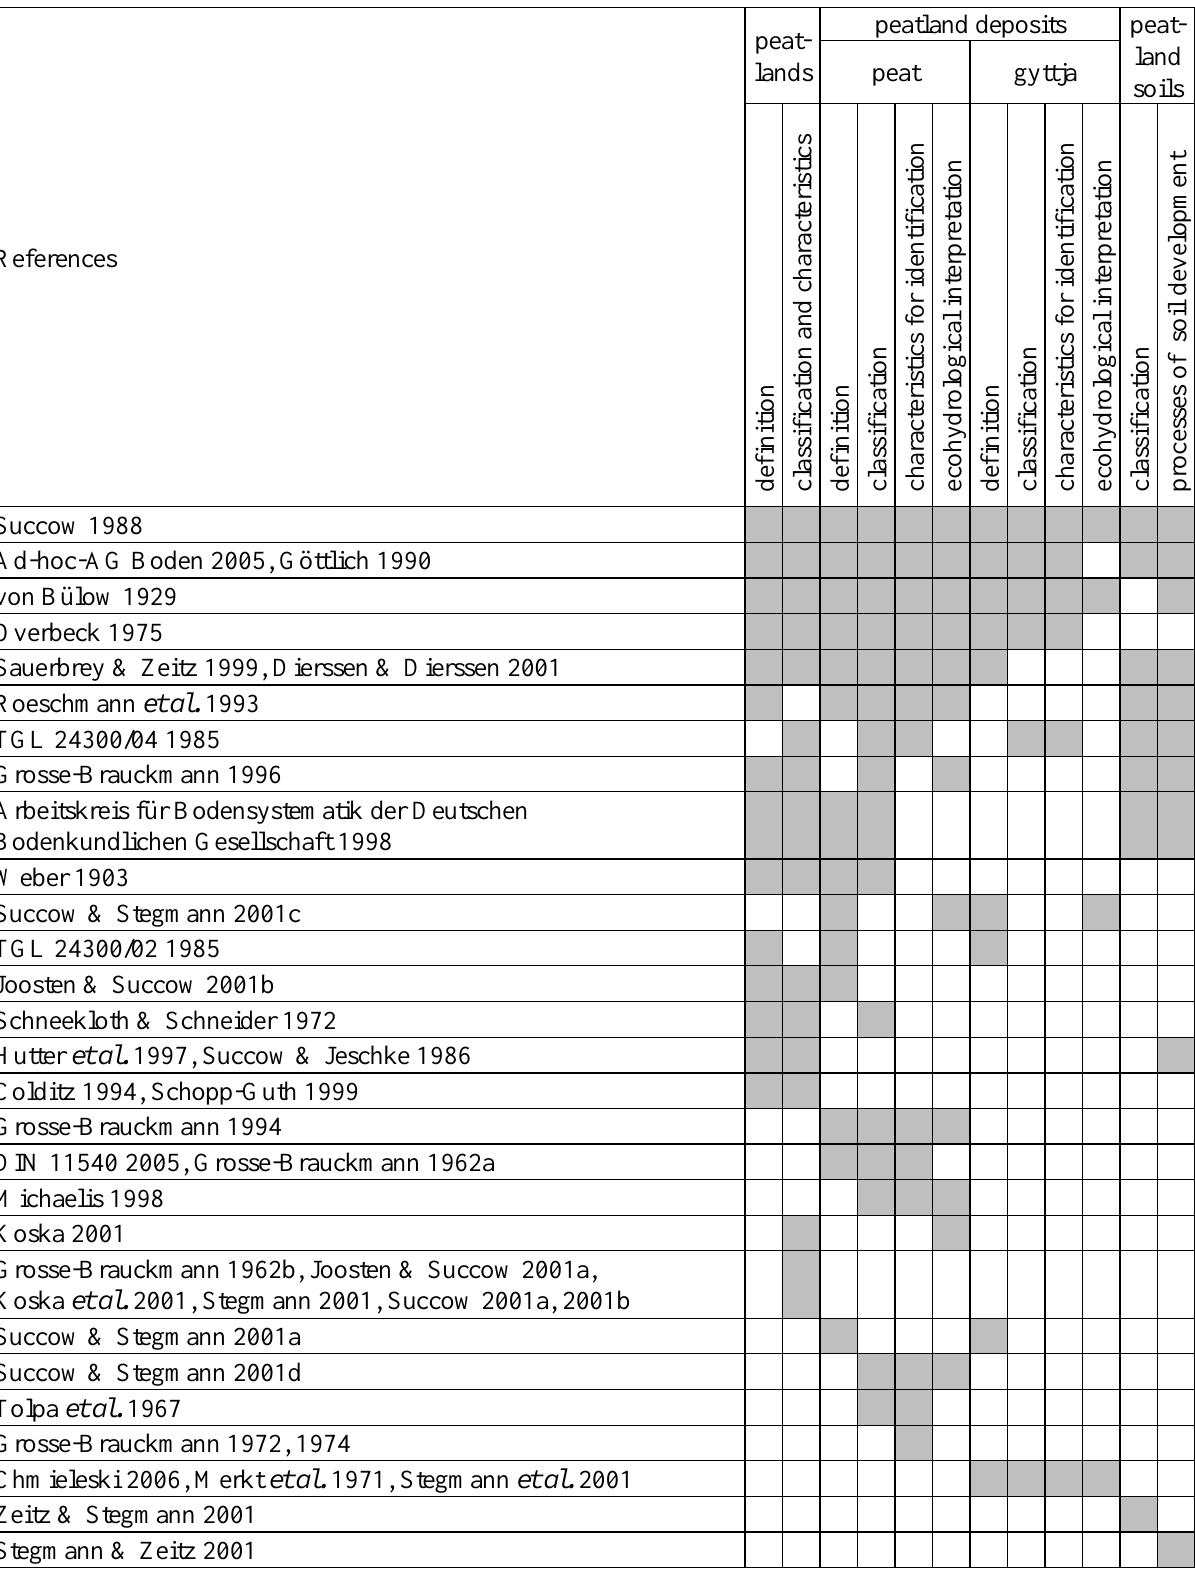
Table A1.1. Classification of topics relating to peatland types and their deposits covered by key German